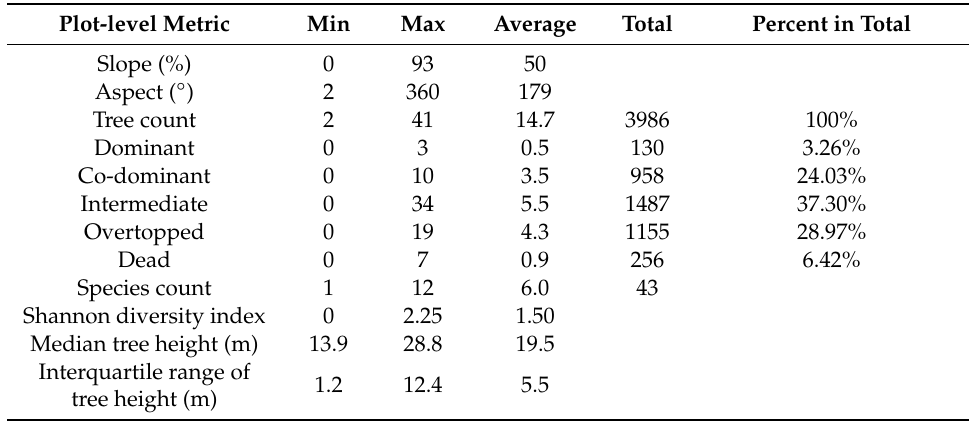
Table 1. Attribute statistics for the 271 plots in the study